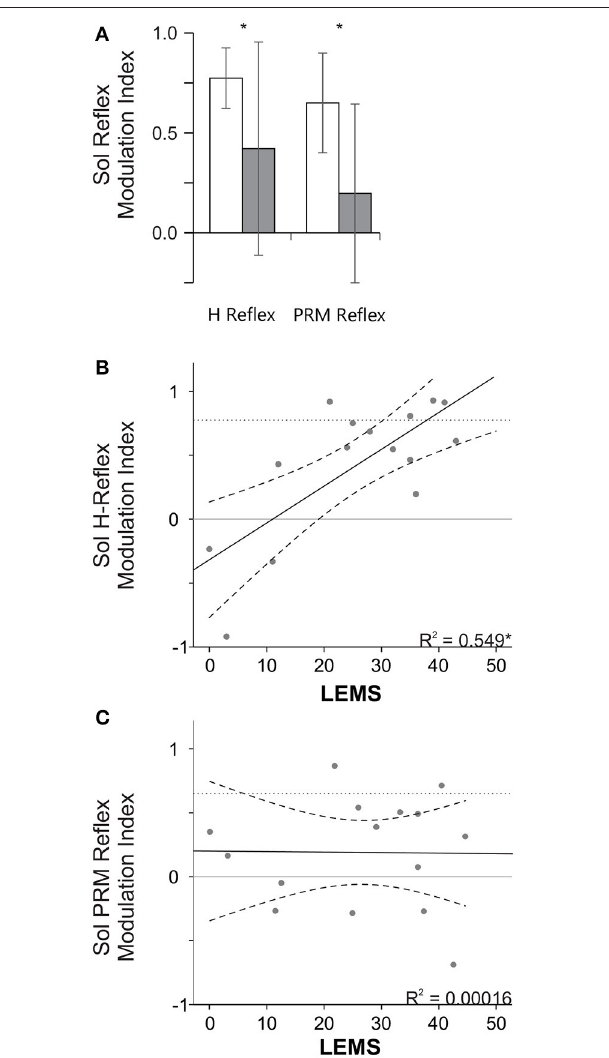
FIGURE 4 | Stance swing modulation index and the relationship to LEMS. (A) Mean ( + SD) modulation index for the NI and SCI groups. Note a larger modulation index indicates more step cycle related reflex modulation (i.e., mid stance > mid swing). *Indicates a significant difference between the NI and SCI groups. (B,C) Correlation between LEMS and the mean H (B) and PRM (C) modulation index. *Indicates a significant Pearson correlation ( p < 0.05). Solid line indicates line of best fit and dashed lines indicate 95% confidence intervals. Dotted horizontal lines represent mean reflex modulation index for the NI group.